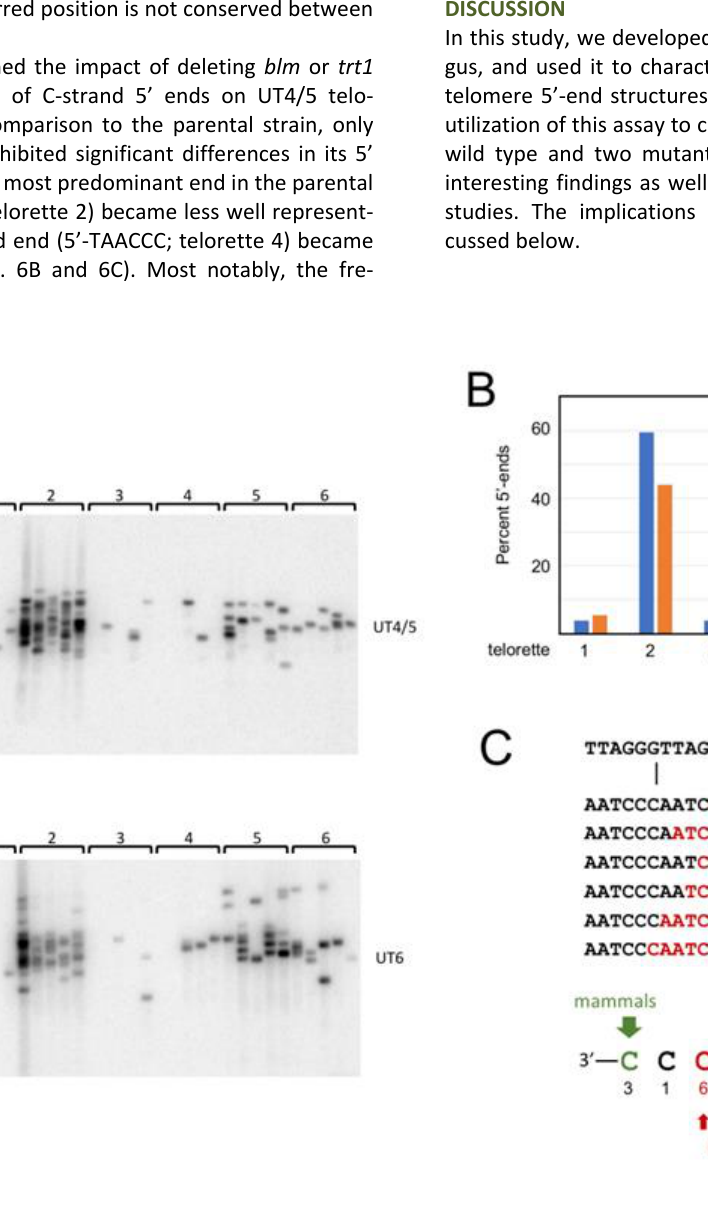
FIGURE 5 : Characterization of the telomere C- strand 5’ end nucleotide in wild type U. maydis . (A) (Top) DNA from Wild type U. maydis was ligated separately to each of six individual telorette oligos, amplified using the UT4/5-F and teltail primers, and then subjected to Southern analysis. (Bottom) Wild type U. maydis DNA was ligated separately to each of six individual telorette oligos, amplified using the UT6-F and teltail primers, and then subjected to Southern analysis. (B) The number of UT4/5 and UT6 STELA products generated by each telorette oligos was determined and plotted as the percentage of total STELA products. (C) The positi on of the 5’ nucleotide identified by each indi- vidual telorette oligos is illustrated. Also indicated are the predominant U. maydis and mammalian 5’ -end